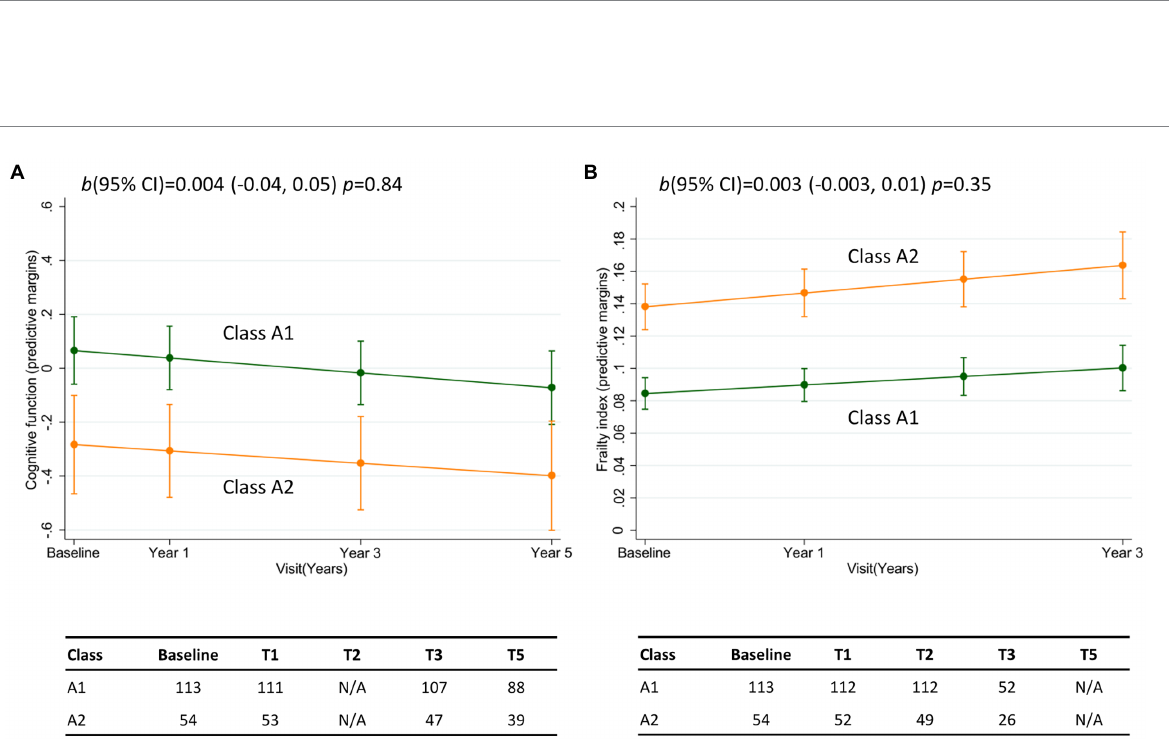
FIGURE 5 Margin plots presenting the two-way interaction between subclasses of the advanced brain age group and the longitudinal change in (A) composite cognitive function, and (B) frailty index. Tables report the frequency of participants who provide data at baseline, and at follow-up assessments. b(95% CI) = unstandardized beta-coefficient of the two-way interaction between class membership and time, and the corresponding 95% confidence